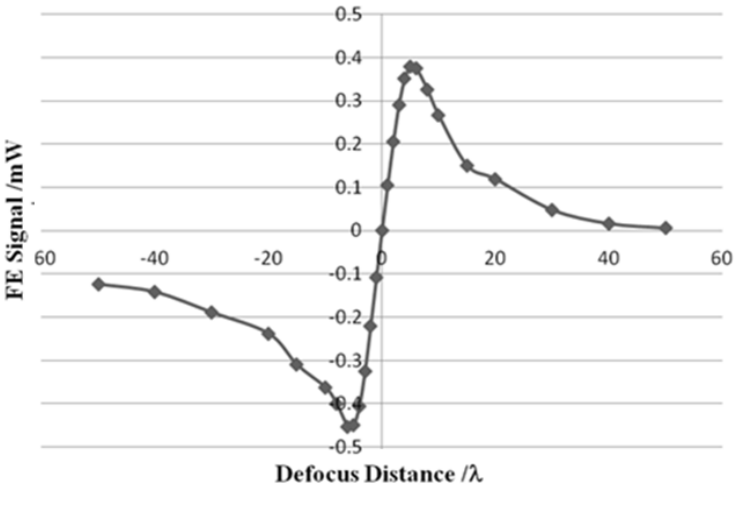
Figure 7. Focusing error signal. The x-axis is normalized defocus distance by